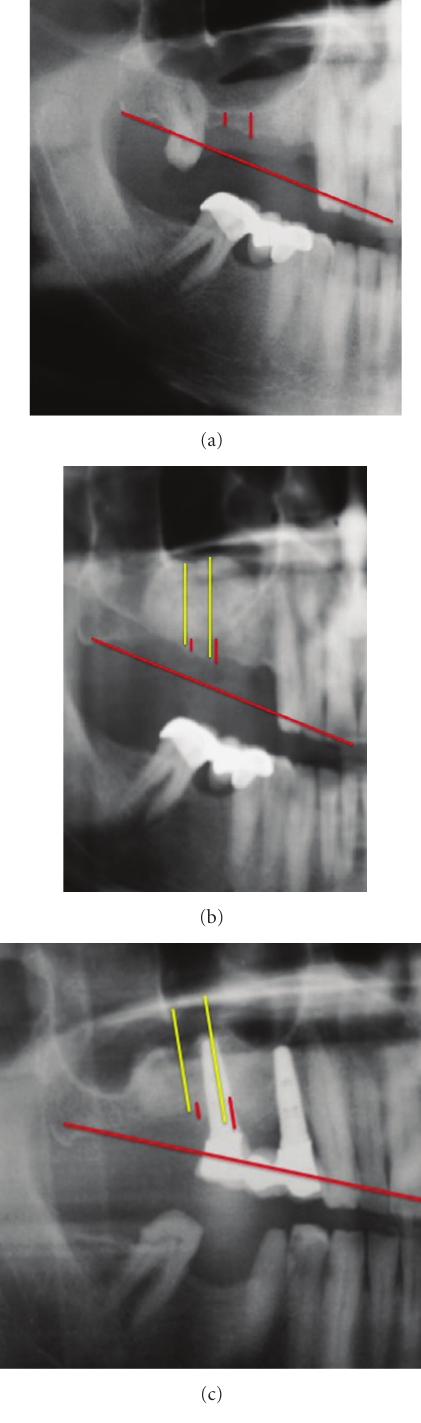
Figure 5: Panoramic X-ray with fixed measuring points at base line (a), after grafting procedure using Bio-Oss after 8-month healing time (b), and after four years of implant placement